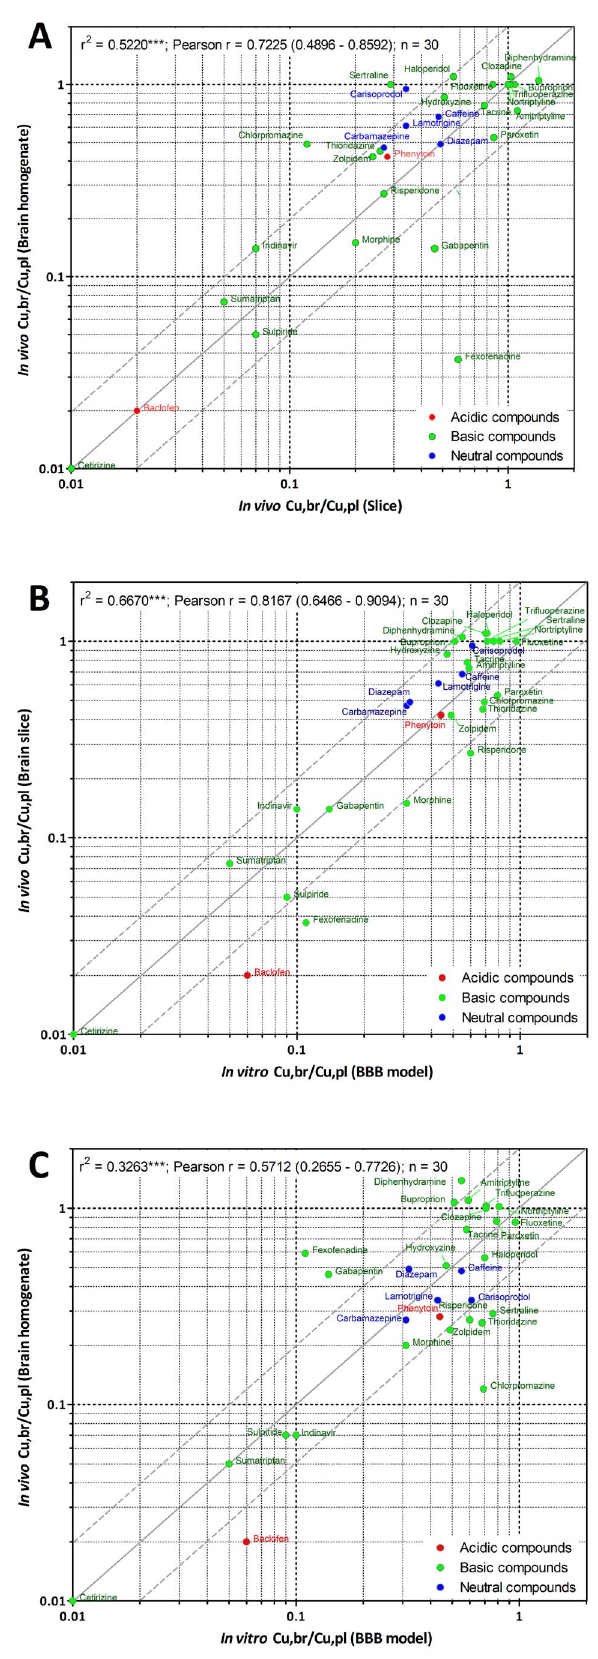
Figure 3. Relationship between in vivo Cu,br/Cu,pl obtained using fu,b from either brain slice or brain homogenate (A); Relationship between in vitro predicted steady-state Cu,br/ Cu,pl and invivo Cu,br/Cu,pl obtained using fu,b from either brain slice (B) or brain homogenate (C). The solid line represents perfect agreement. The dashed lines represent a 2-fold over- or underestimation compared with in vivo